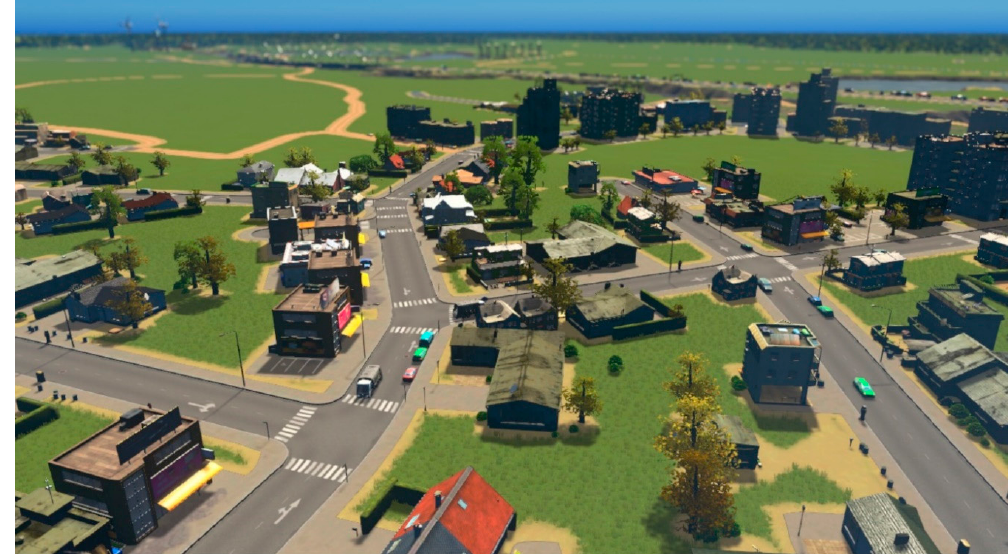
Figure 6. A closeup of the resulting playable model of Svit in Cities: Skylines.